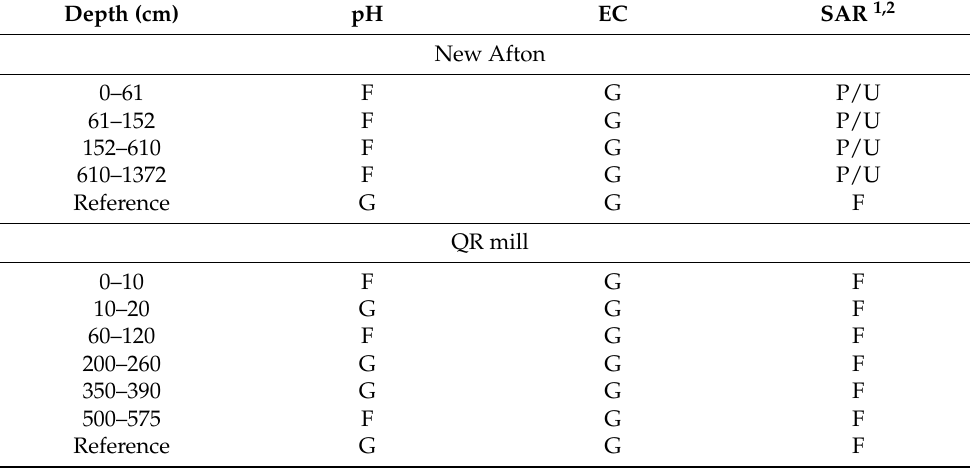
Table 1. Reclamation suitability ratings for the topsoil stockpiles in grassland (New Afton) and forested (QR mill) ecosystems. G = good; F = fair; P = poor; U = unsuitable [20]. Depth (cm) pH EC SAR